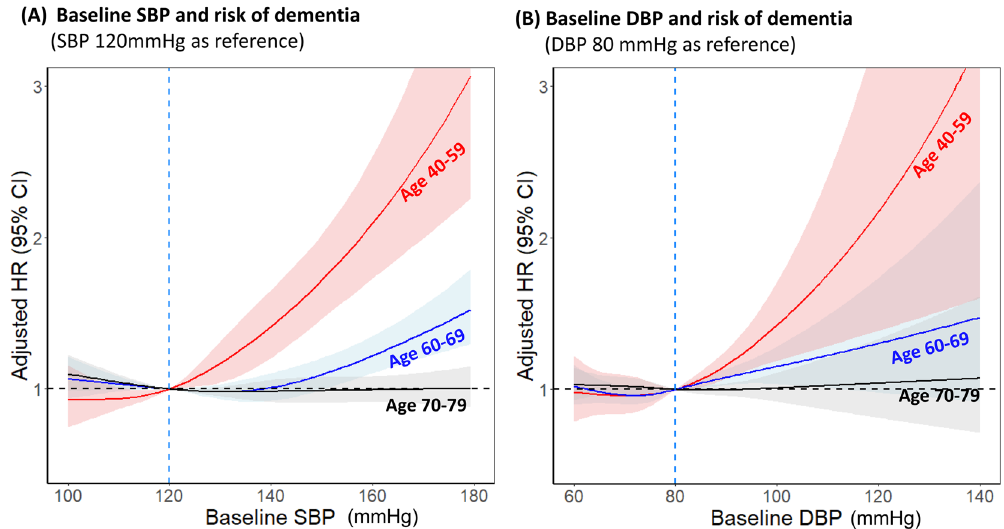
Figure 3. Adjusted HRs for risk of dementia according to baseline ( A ) SBP and ( B ) DBP measured in different age subgroups. Spline curves represent HRs adjusted for age, sex, income, body mass index, alcohol consumption, smoking, physical activity, hypothyroidism, hyperthyroidism, major bleeding, atrial fibrillation, heart failure, diabetes mellitus, dyslipidemia, myocardial infarction, peripheral artery disease, chronic kidney disease, chronic obstructive pulmonary disease, liver disease, malignant neoplasm, and medication at baseline (e.g. aspirin, statin, oral anticoagulant, ß-blocker, RAAS blocker, calcium channel blocker, diuretics and alpha blocker). Subjects with baseline SBP 120 mmHg or DBP 80 mmHg were used as reference. CI confidence interval, DBP diastolic blood pressure, HR hazard ratio, SBP systolic blood pressure.